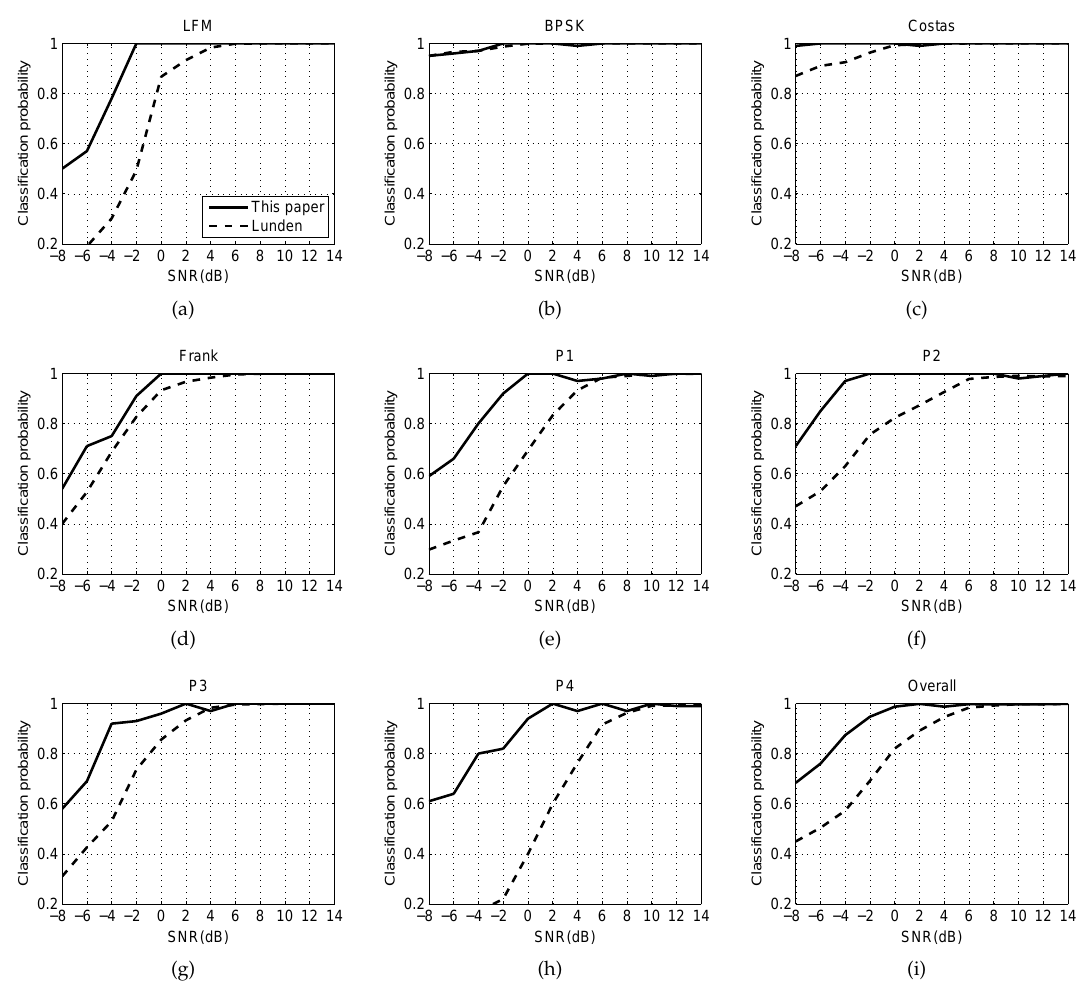
Figure 8. In this figure, ( a )–( h ) are the probabilities of 8 types of radar waveforms that measured by the testing data respectivel; ( i ) is the successful rate of overall